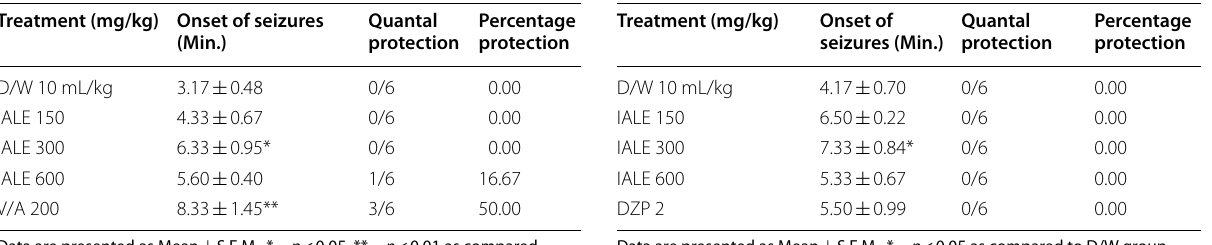
Table 5 Effect of Ipomoea asarifolia ethanolic leaf extract on strychnine-induced seizures in